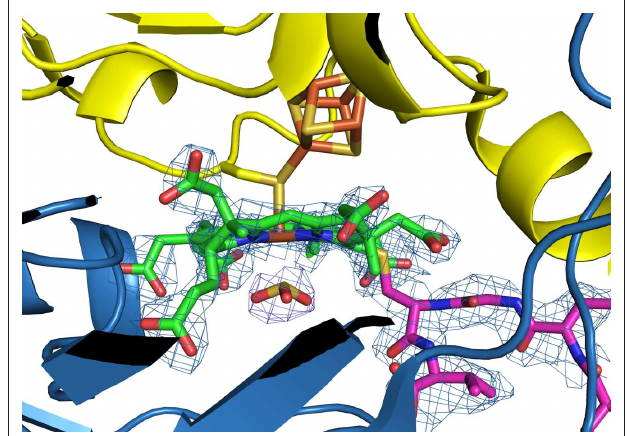
Figure 2 | Zoomed view of siroheme B – [4Fe–4S] cluster bridged by a cysteine residue (Cys193B). The covalent bond between Cys104C (DrsC is magenta) and siroheme B is displayed. A SO 32 − is observed at the distal site of the catalytic siroheme. The 2Fo–Fc electron-density map is contoured at 1.5 σ . DsrA is displayed in blue and DsrB in yellow. Atom color code: C, green; N, blue; Fe, orange; S, gold, and